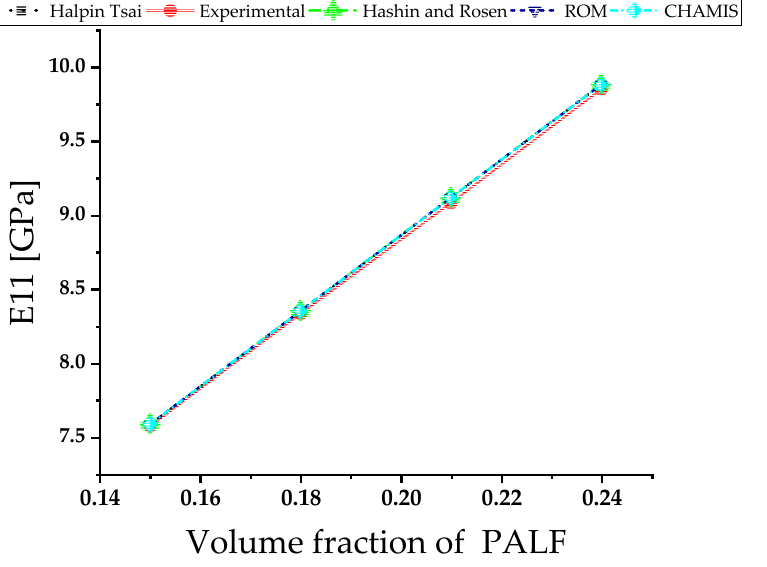
Figure 7. Comparison (analytical vs. exp) of Longitudinal Young’s modulus E 11 of PALF/epoxy in terms of volume fractions.